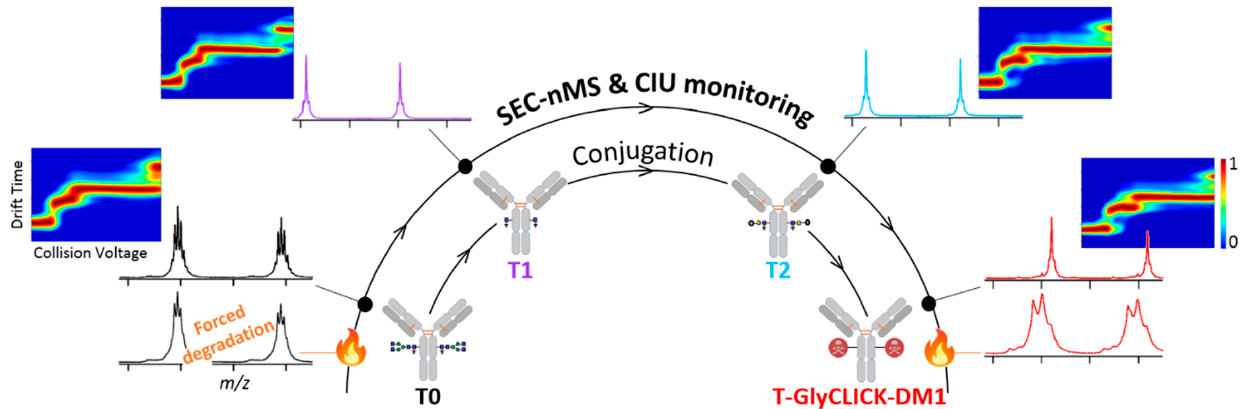
Figure 2. Analytical workflow used to monitor the conjugation of T-GlyCLICK-DM1.